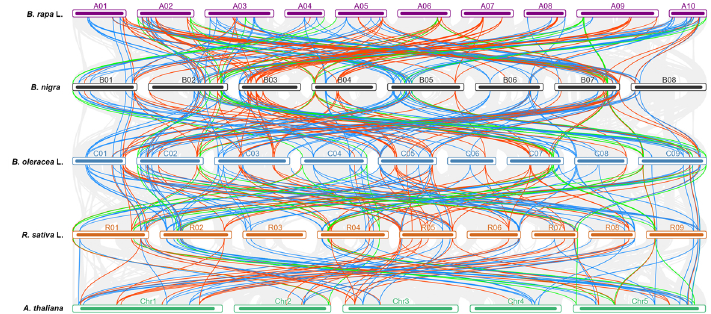
Figure 4. Syntenic relationship among A. thaliana , B. rapa , B. nigra , B. oleracea , and R. sativus con- structed according to orthologous gene pair positions. Different color curves linked AtCCT genes with their orthologous genes in B. rapa , B. oleracea , and R. sativus